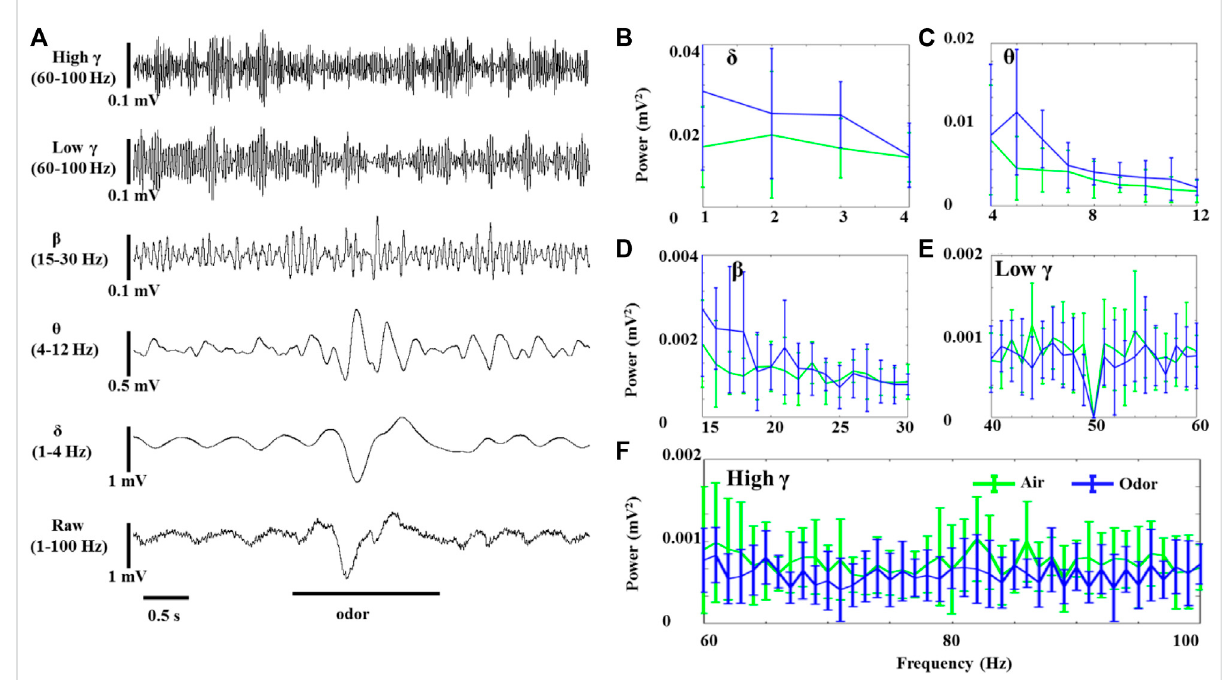
FIGURE 1 Odor-evoked LFP (1 – 100 Hz) responses in the OB of awake rats. (A) Typical OB LFP traces recorded under nonanoic acid (NA) stimulation. Shownaretheband-pass fi lteredtracesof δ (1 ‒ 4 Hz), θ (4 – 12 Hz), β (15 – 30 Hz),low γ (40 – 60 Hz),andhigh γ (60 – 100 Hz)activity,aswellasfullband LFP (1 – 100 Hz).The mean fast Fourier transform(FFT)power spectrum shows thedistributionof energyfrom the δ - (B) , θ - (C) , β - (D) , low γ - (E) , and high γ -bands (F) across three rats under air (green line) and nonanoic acid (NA) (blue line) stimulation. The trial-averaged data are presented as the mean ± SEM, n = 12, 4 trials per